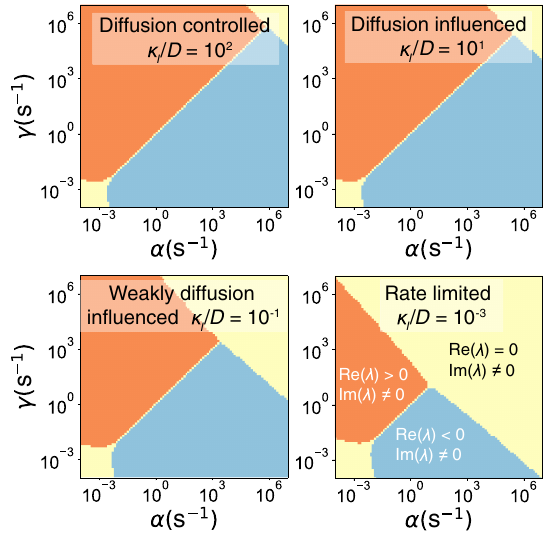
FIG. 7. Phase diagram of LV oscillators when the intrinsic reaction rate is finite for different intrinsic rates κ at I D ¼ 1 μ m 2 = s. We use the classification scheme provided in Ref. [18] to designate different regimes. We observe that fine- tuned oscillation persists even when the reactions are limited by the intrinsic reaction rates, although the corresponding parameter range narrows as κ is decreased. These results suggest that the I effect of diffusion may be felt even when the reaction rate is controlled almost entirely by the intrinsic rate κ I